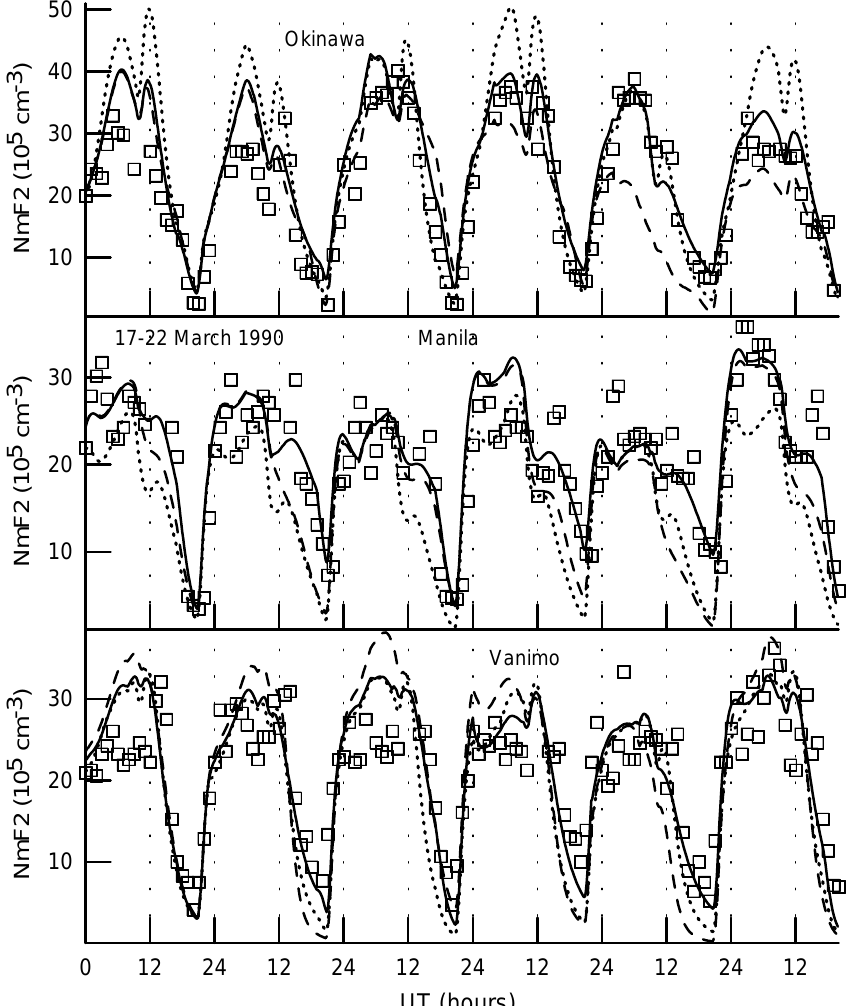
Fig. 10 Fig. 10. Observed (squares) and calculated (lines) Nm F2 above the Vanimo (bottom panel), Manila (middle panel), and Okinawa (top panel) ionosonde stations during 17–22 March 1990. The dashed lines show the results produced by the model with the original neutral HWM90 wind and the same values of the zonal electric field and the NRLMSISE-00 neutral densities as for the solid lines. The results shown by the dotted lines were calculated by the model, which uses the original quiet vertical drift velocity of Scherliess and Fejer (1999) (dotted line in the bottom panel of Fig. 2) and the same corrections of the NRLMSISE-00 neutral densities and neutral wind as for the solid